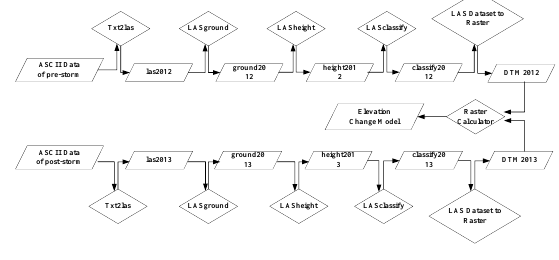
Figure 2. Elevation change model acquisition flow